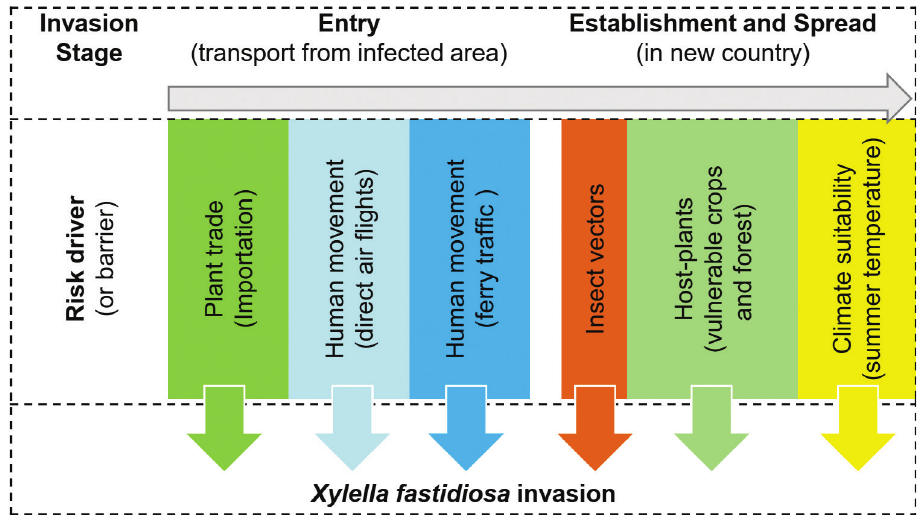
Figure 2. Overview of the invasion process of Xylella fastidiosa into a new country, based on the general framework of Blackburn et al. (2011). The diagram highlights specific risk indicators for each stage of invasion that were considered in our risk-ranking